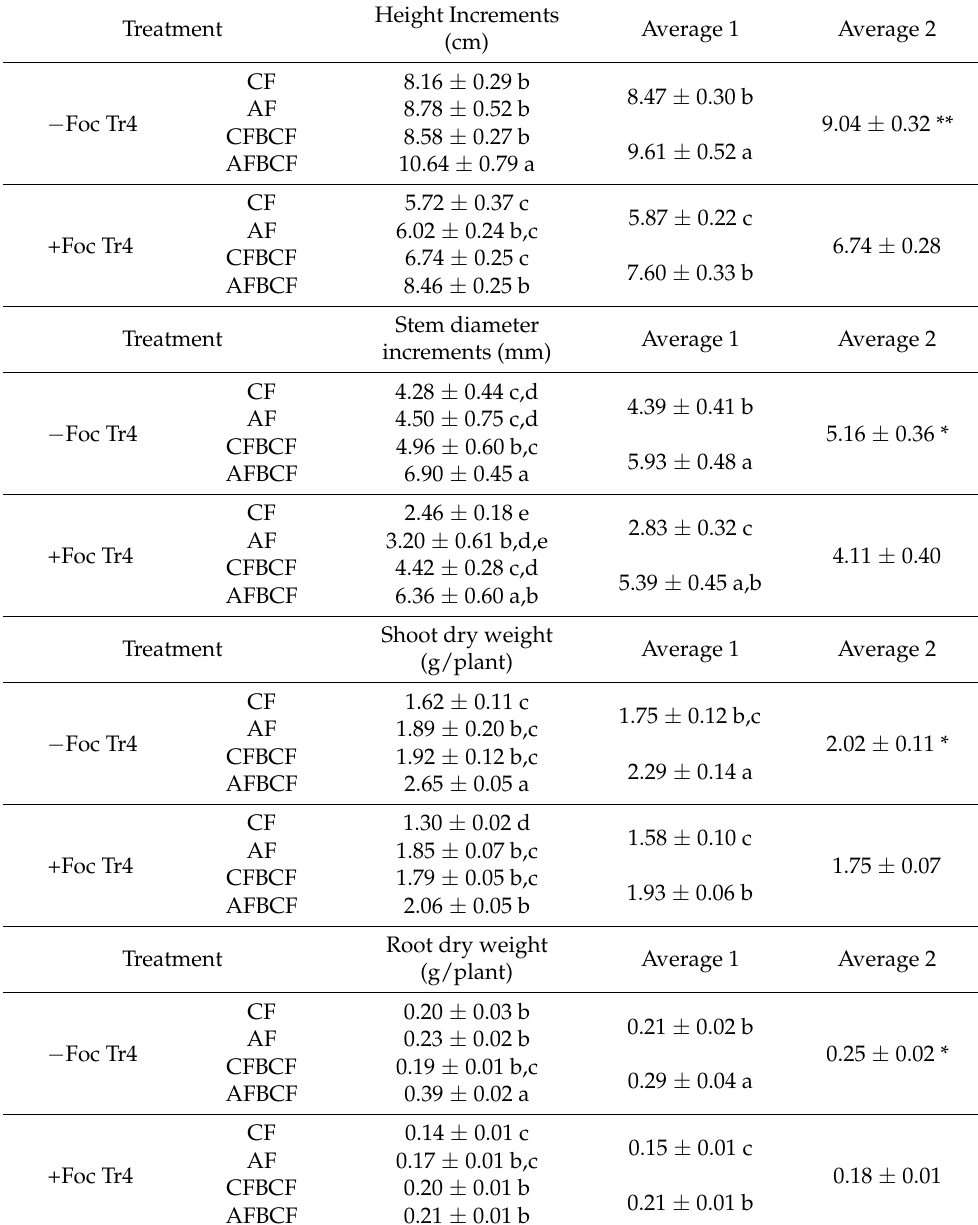
Table 2. Effect of alkaline fertilizer and biocontrol fungi on banana height and stem diameter increments, shoot and root dry weight 60 days after Foc Tr4